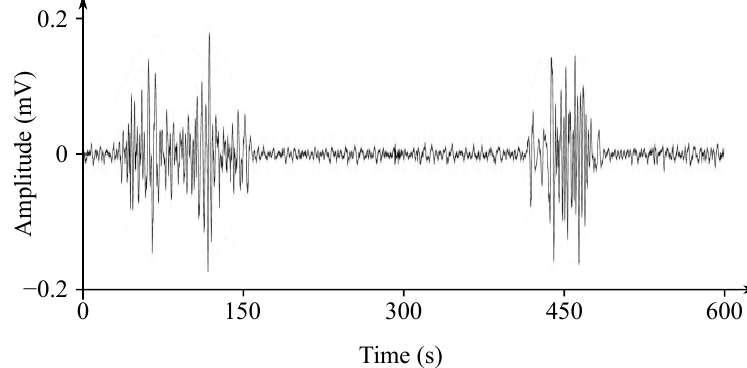
Figure 14. Plot of a recorded EHG signal.